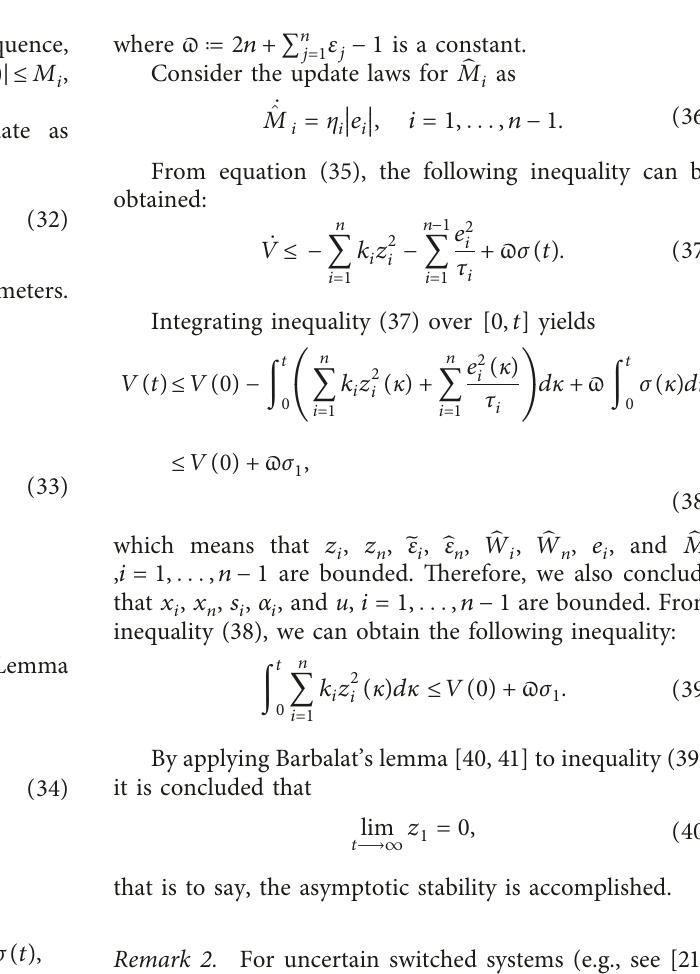
r and the output signal y